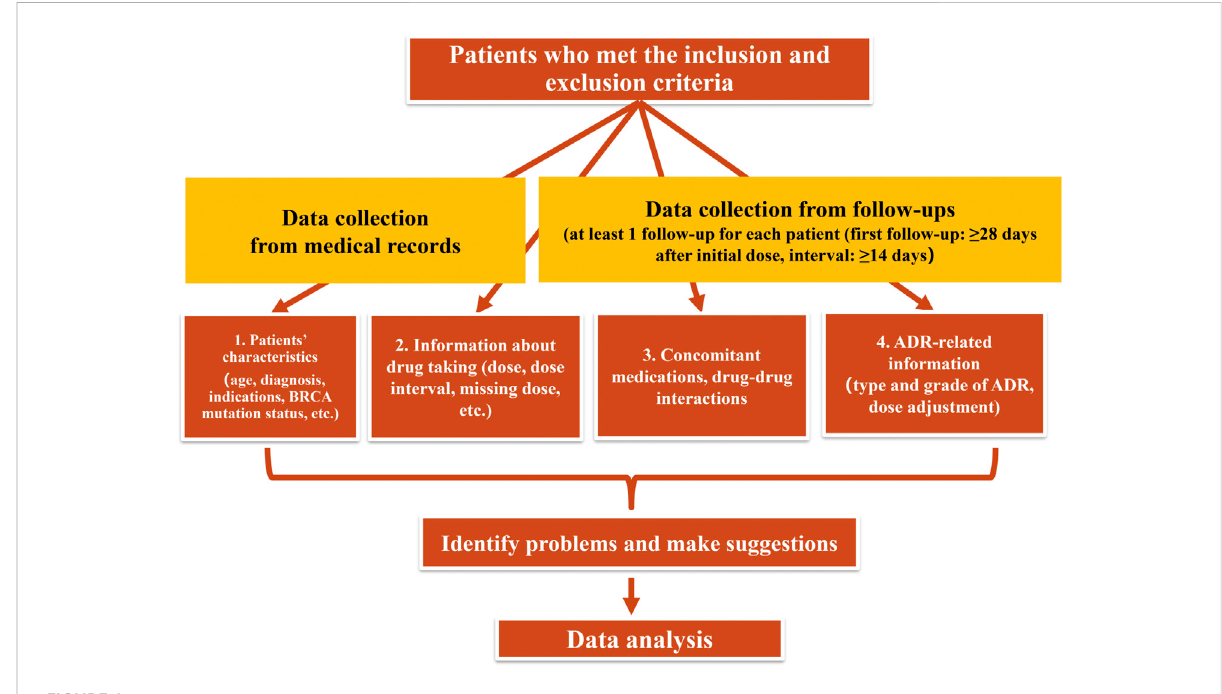
FIGURE 1 Flowchart of the study.